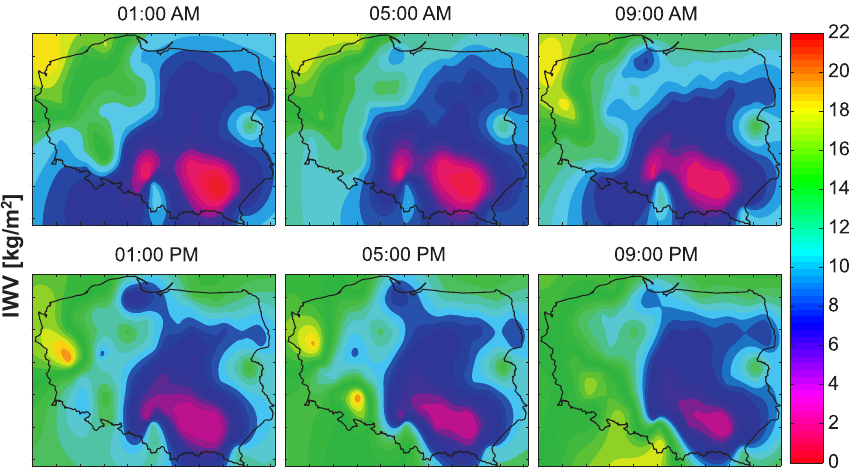
Fig. 9. Example of the Integrated Water Vapour (IWV) 2-D distribution over the area of Poland calculated for 7 November 2011, shown as a time series with 4h interval.